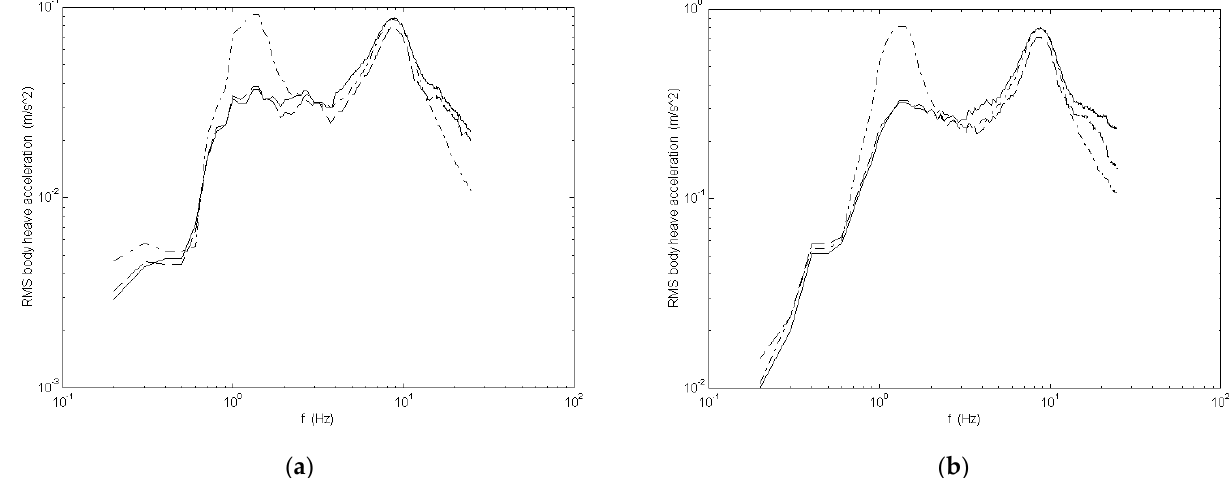
( b ) Figure 7. RMS of suspension stroke. ( a ) smooth road; ( b ) rough road. 4.3. Full Car Model Simulation A full car dynamic model that had eight degrees-of-freedom including roll, pitch, heave, driver seat, and four wheel vertical motions was simulated for more realistic ve- hicle behavior. Table 2 shows the model parameters of the vehicle under advanced de- velopment with in-wheel motors on the rear axle. In order to evaluate the performance variation for the change in damping coefficient, a simulation was performed for the damping coefficients listed in Table 3. Note that the fourth passive damping coefficient in Table 3 was the same as the passive damping coefficient in Table 2. Table 2. Model parameters for a full car. Parameter Value Effective weight of front wheel ( (cid:1865) (cid:3048)(cid:3033)(cid:3039) , (cid:1865) (cid:3048)(cid:3033)(cid:3045) ) 54 kg Effective weight of rear wheel ( (cid:1865) (cid:3048)(cid:3045)(cid:3039) , (cid:1865) (cid:3048)(cid:3045)(cid:3045) ) 68 kg Weight of sprung mass ( (cid:1865) (cid:3046) ) 1754 kg Pitch moment of inertia ( (cid:1836) (cid:3109) ) 3012 kg m 2 Roll moment inertia ( (cid:1836) (cid:3087) )